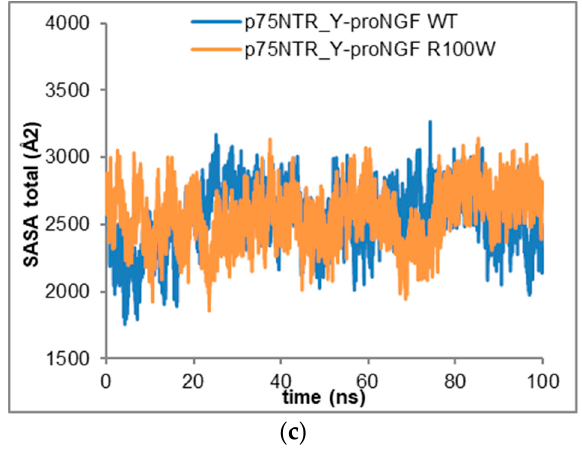
Figure 6. Time-evolution Solvent Accessible Surface Area trajectories of the complexes: ( a ) p75NTR/NGF, ( b ) p75NTR_X/proNGF, and ( c ) p75NTR_Y/proNGF. The p75NTR/NGF WT complex showed significantly lower SASA trajectories (i.e., 2280.23 ± 159.15 Å 2 ) with respect to those of the p75NTR/NGF R100W complex (i.e., 2657.02 ± 177.08 Å 2 ), suggesting a reduction of the intermolecular interaction surface due to the R100W mutation, which is quite a stable effect, taking into account the small fluctuations in the total SASA profile of both complexes (Figure 6a). Analogously, the R100W mutation causes an increase in the hydrophobic SASA from 1086.15 ± 122.35 Å 2 to 1253.44 ± 106.87 Å 2 (Figure 7a), as well as of the hydrophilic SASA from 1194.16 ± 109.44 Å 2 to 1403.65 ± 97.10 Å 2 (Figure 8a).